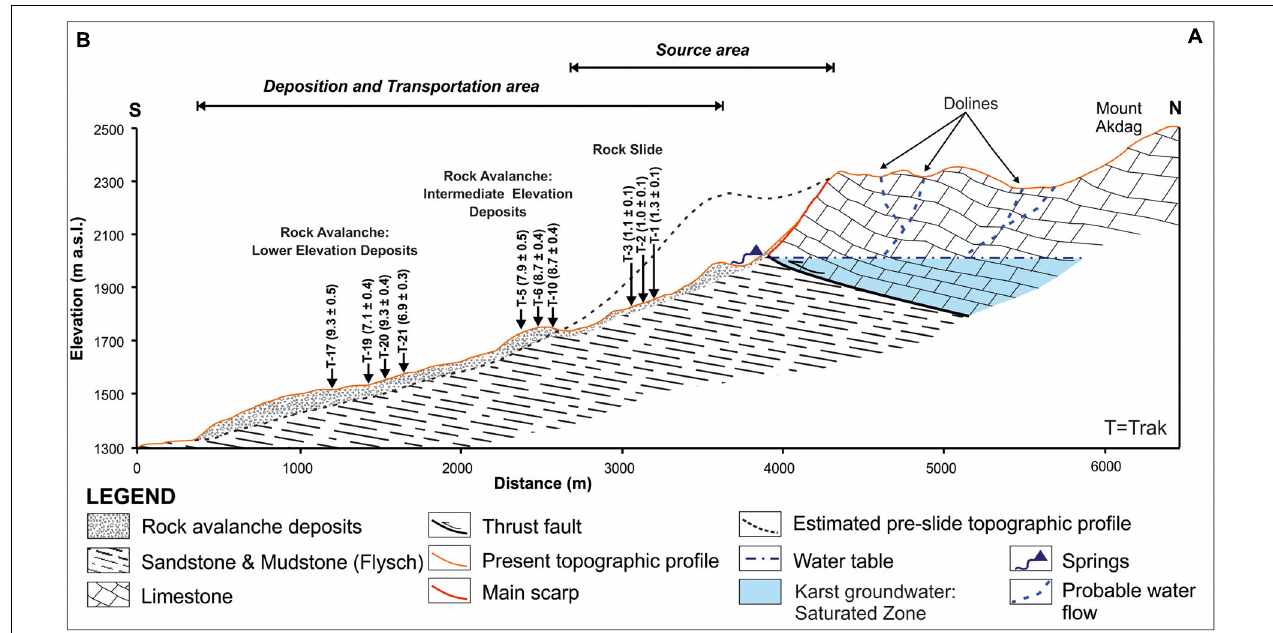
FIGURE 9 | Cross-section of Akdag rock avalanche and distribution of 36 Cl surface exposure ages (profile line is shown in Figure 4 with a white dashed